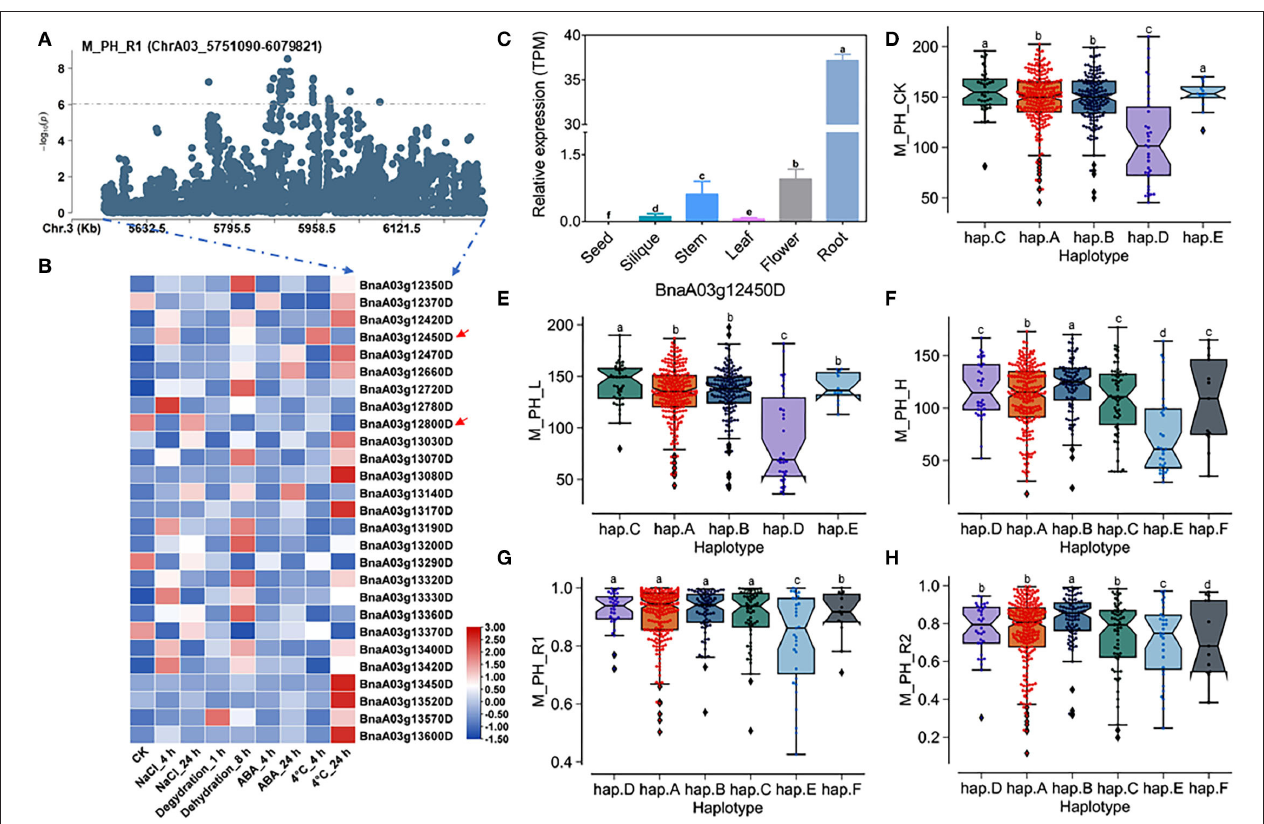
FIGURE 6 | Analysis of candidate genes within the QTL qSAT.A03 on ChrA03 associated with M_PH_R1. (A) A zoom-in view of the Manhattan plot on ChrA03 from 5,751,090 to 6,079,821 bp in the QTL qSAT.A03 region. These points represented the log-transformed P -values for variants from GWAS of the ratio of plant height between low-salt-alkali and control conditions at the mature stage (M_PH_R1). (B) Gene expression of candidate genes identified within 200kb upstream or downstream of the significantly associated SNPs under 200-mM NaCl, 25- µ M ABA, 4 ◦ C low temperature conditions for 4 and 24-h dehydration conditions for 1 and 8h in B. napus cultivar “ ZS11 .” (C) Expression levels of BnA03g12450D in different tissues of B. napus cultivar “ ZS11 .” Values were means ± SD ( n = 3 replicates), and different letters significantly indicate differences at p < 0.05 using two-way ANOVA. (D–F) Boxplots of haplotypes of BnA03g12450D for absolute value of